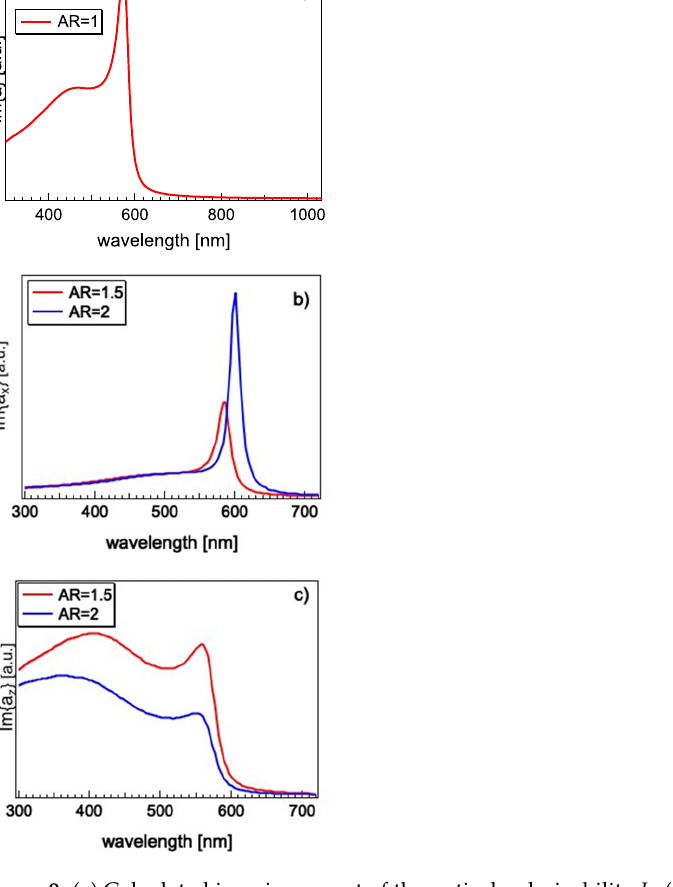
Figure 9. ( a ) Calculated imaginary part of the optical polarizability Im( α ) from the Maxwell–Garnett model of a spherical Cu NP embedded in MgO (AR = 1); ( b ) x component Im( α x ) calculated for an oblate ellipsoid with AR = 1.5 and AR = 2. x is the direction along the major axis, parallel to the surface of the support; ( c ) z component Im( α z ) , normal to the surface for AR = 1.5 and AR = 2. Table 1. Experimental and theoretical wavelength positions of the LSPR for Cu/MgO NPs. The results for AR = 1.5 and AR = 2 are, respectively, maxima of Im( α x ) and Im( α z ) . Cu/MgO Cu/MgO Cu/MgO (exp) Cu/MgO Im(a) Im( α z ) Im( α x ) 554 Table 2. Experimental wavelength positions of the LSPR for Cu and Cu post-ox NPs, and theoretical positions of the LSPR calculated for Cu NPs in vacuum. The results for AR = 1.5 are, respectively, maxima of Im( α x ) and Im( α z ) . Cu (exp)